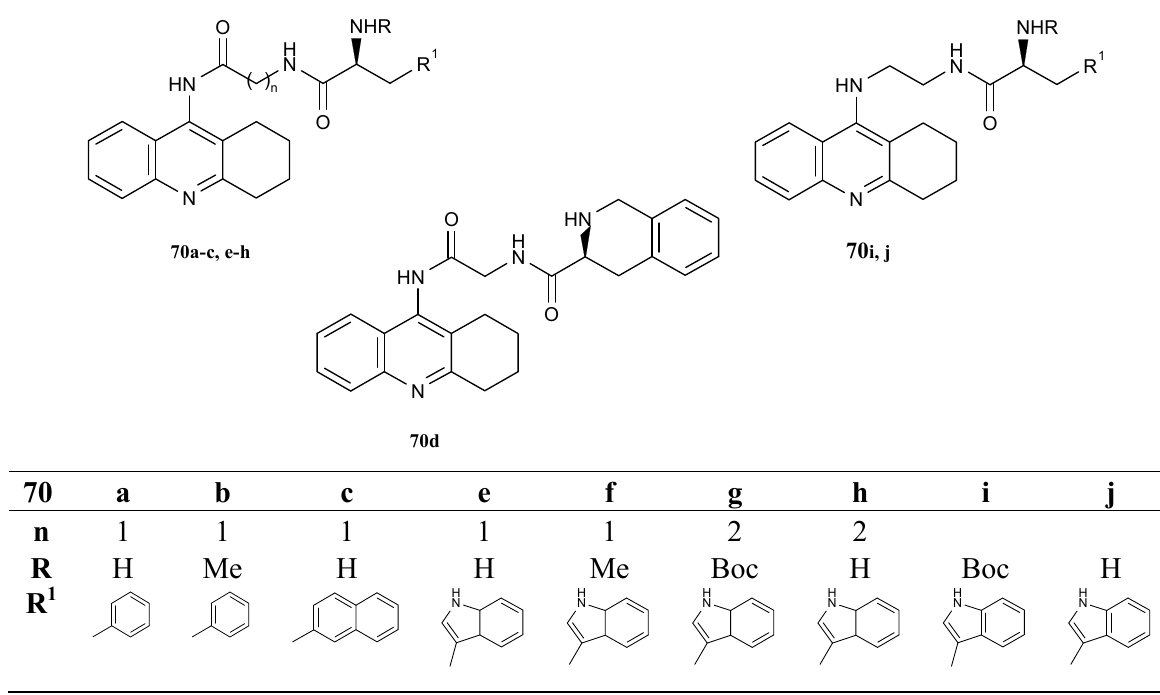
Figure 15. Tacrine heteroligands containing peptidic tethers 70a–j